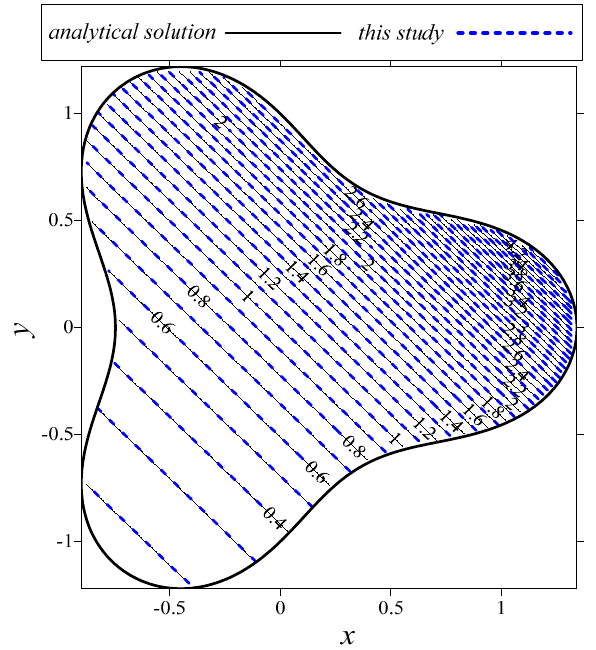
Figure 7. Comparison of the numerical solution with the exact solution.